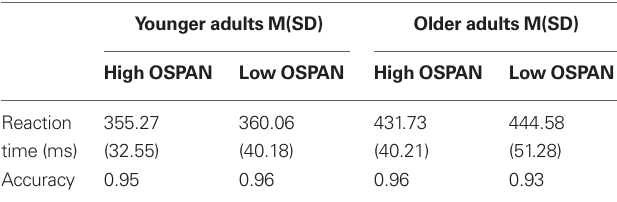
Table 3 | Mean reaction time and accuracy scores (with SD in parentheses) for the two age groups and the two OSPAN